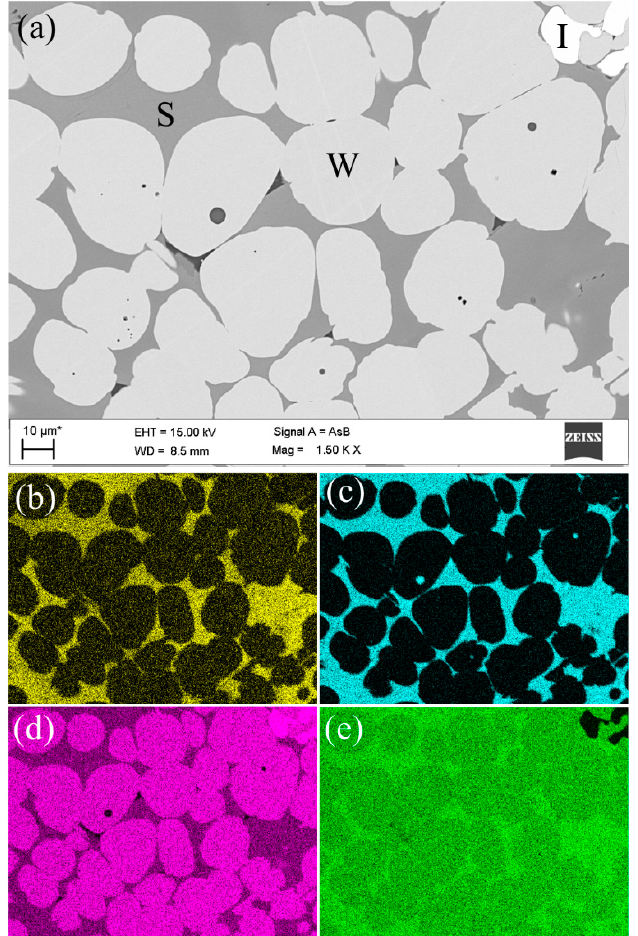
Figure 11. FESEM-EDS mapping of elements of softened pellets sized 10–12.7 mm. Figure ( a ) is the original backscattered electron image, and the EDS mapping of elements is presented in: ( b ) Mg, ( c ) Si, ( d ) Fe and ( e ) O. “I” stands for metallic iron, “W” for wüstite and “S” for slag.